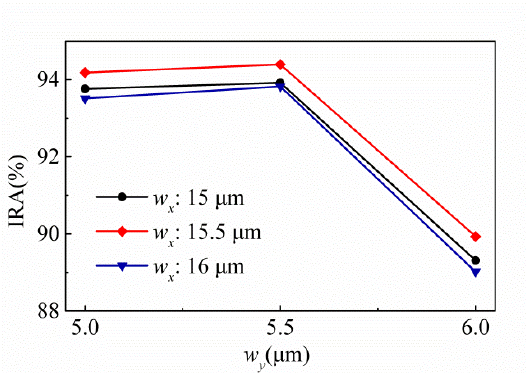
Figure 5. Variances of the IRA with different w y by the function of w x for the thermopiles with SA type ( a ) and MA type ( b ) of SRHA, where the solid lines with triangle, square, and round represent the cases of w y = 4 μm, w y = 5 μm, and w y = 6 μm, respectively.